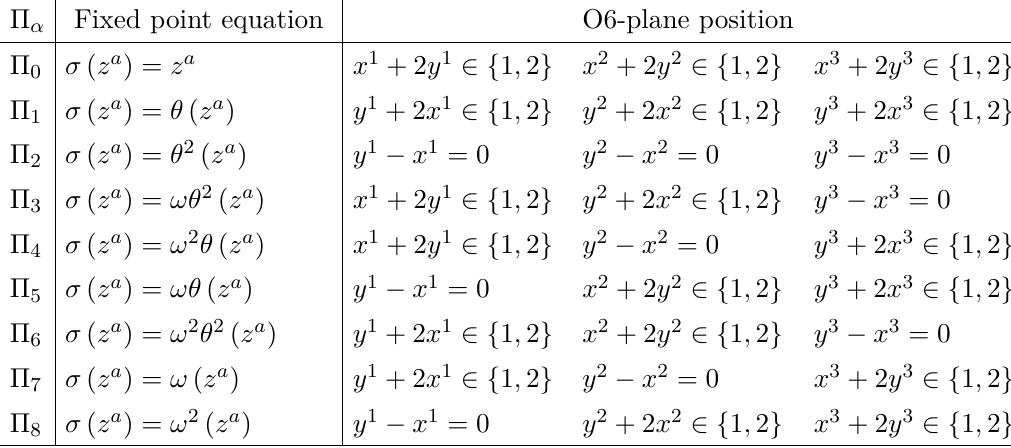
Table 3. O6-planes in T 6 / Z 3 × Z 3 .